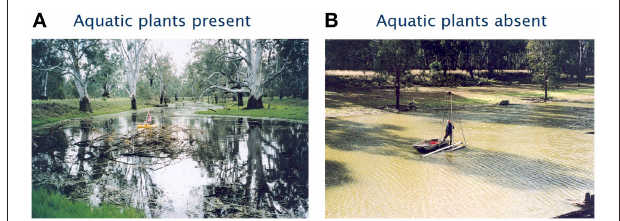
FIGURE 1 | Two billabongs from the Murray Darling Basin (A), clearwater macrophyte-dominated; (B) turbid